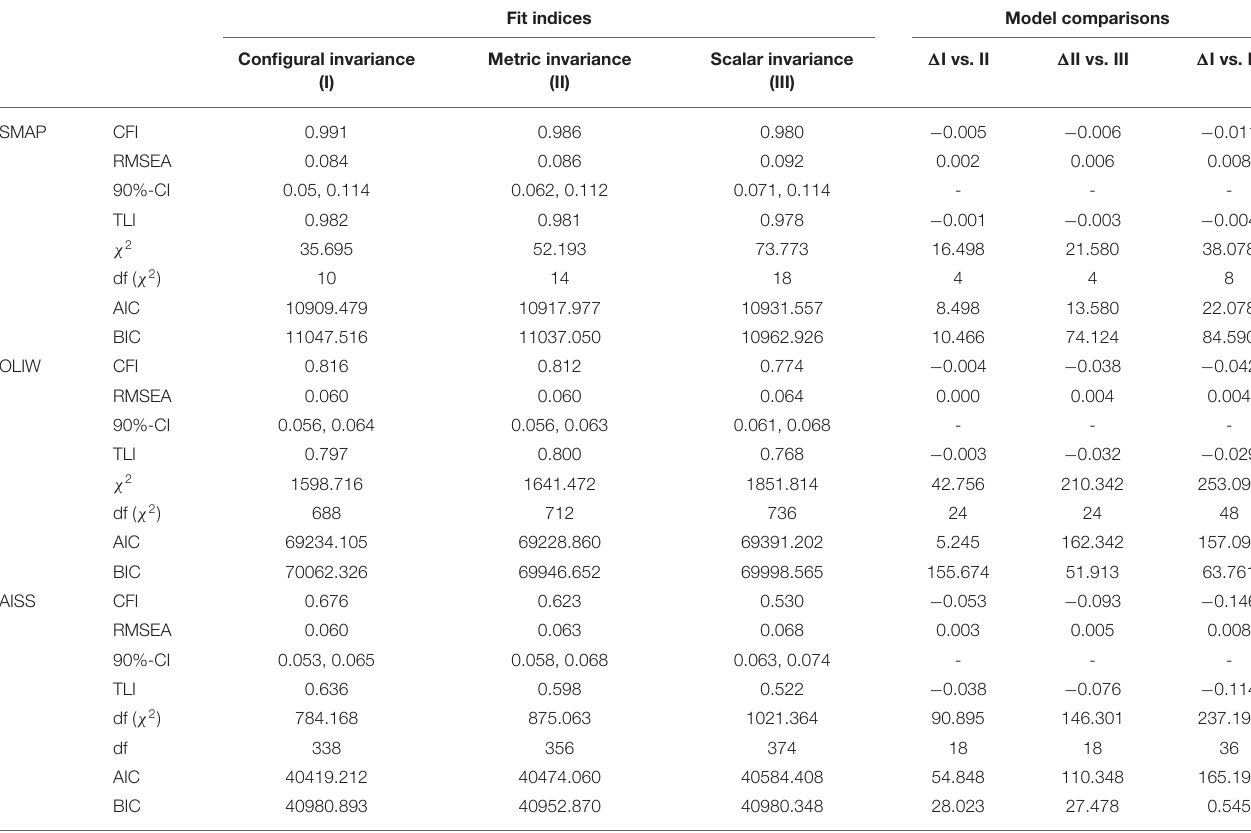
TABLE 2 | Measurement invariance analysis of the SMAP, OLIW facets, and AISS dimensions in 339 librarians and 399 police officers. Fit indices